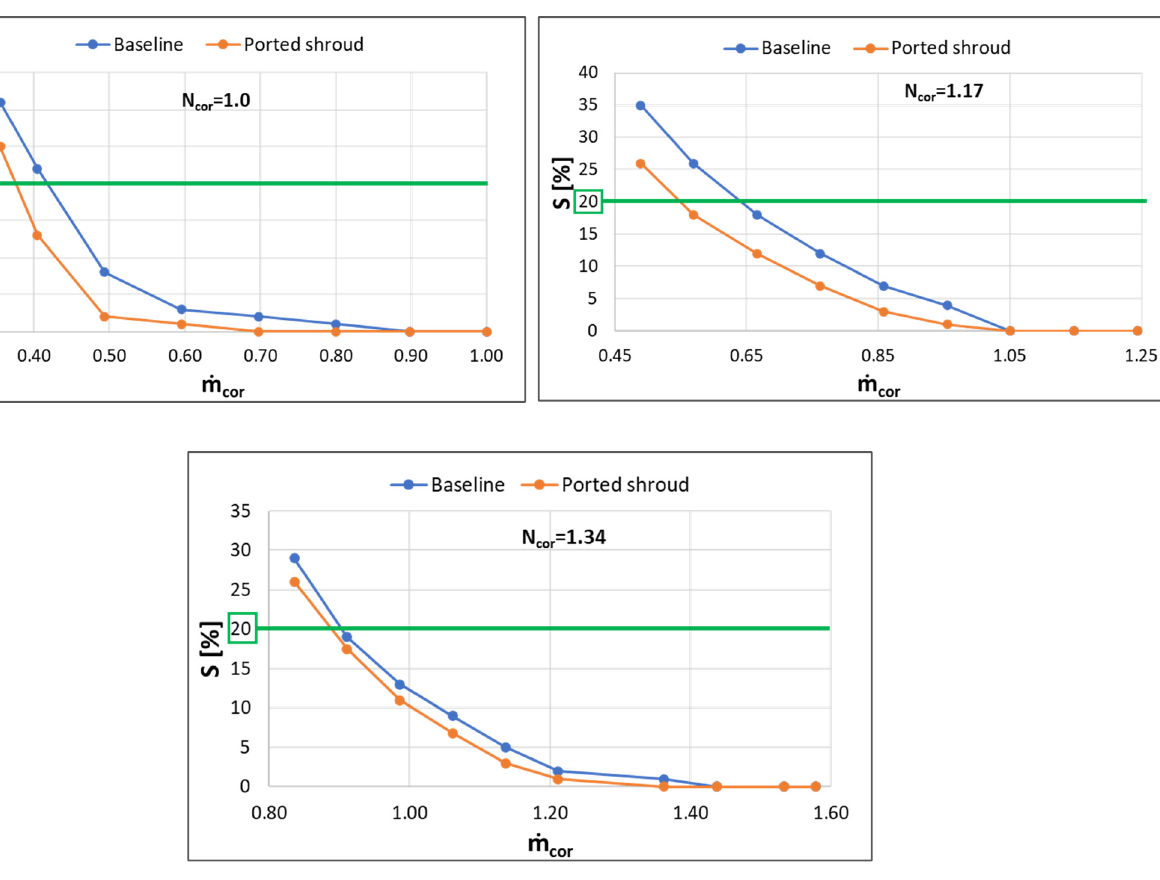
Figure 18. Variation in the parameter S with the mass flow rate, for different rotational speeds, for the configurations with ported shroud and baseline.